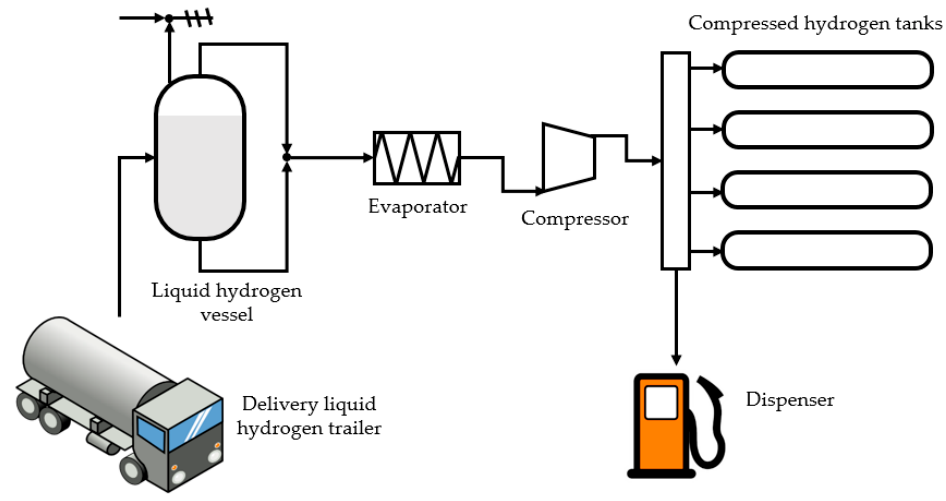
Figure 11. Schematic diagram of typical hydrogen refueling station with liquid hydrogen delivery.